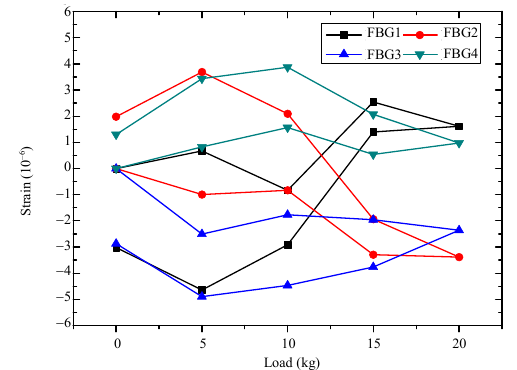
Fig. 8 Relative error between the FBG sensors and the resistance strain